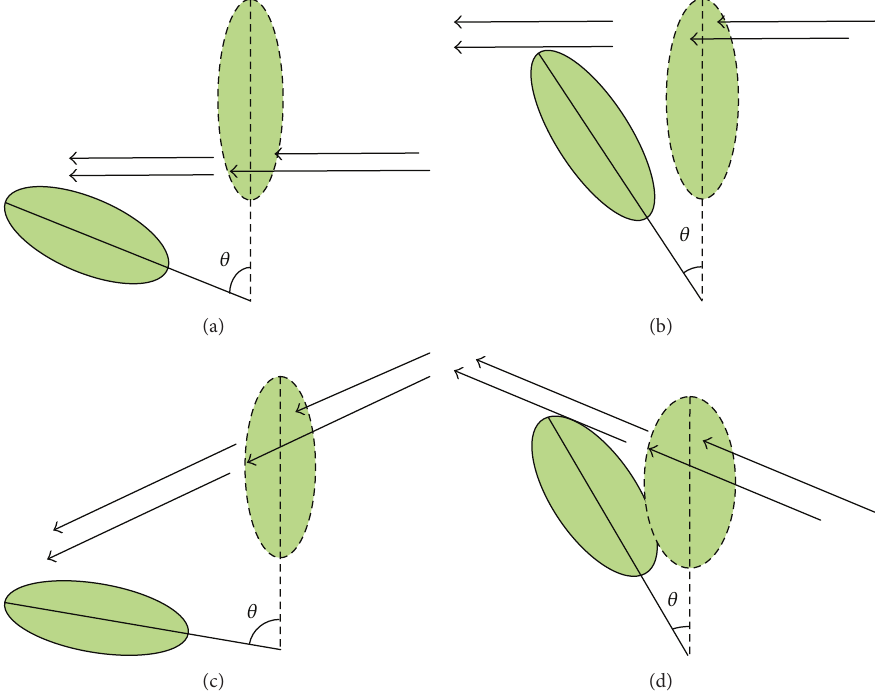
Figure 6: Various responses to wind duration and velocity on leaf blade: (a) wind is perpendicular to blade and hits its lower half, (b) wind is perpendicular to blade and hits its upper half, (c) wind is oblique to blade and hits its upper half, and (d) wind is oblique to blade and hits its upper